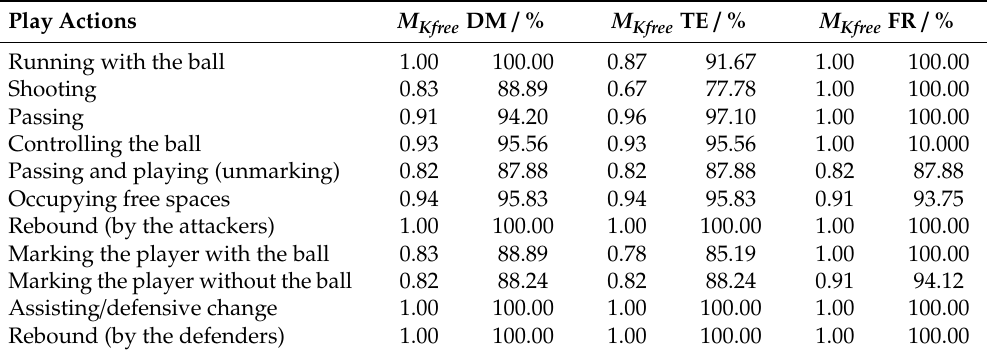
Table 9. Inter-rater reliability values and percent overall